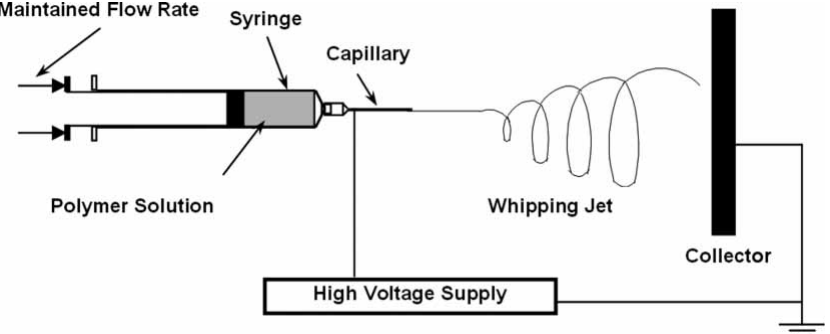
Figure 2. Schematic of the general set up for electrospinning. Reproduced with permission from [58]. Copyright 2008 Taylor &